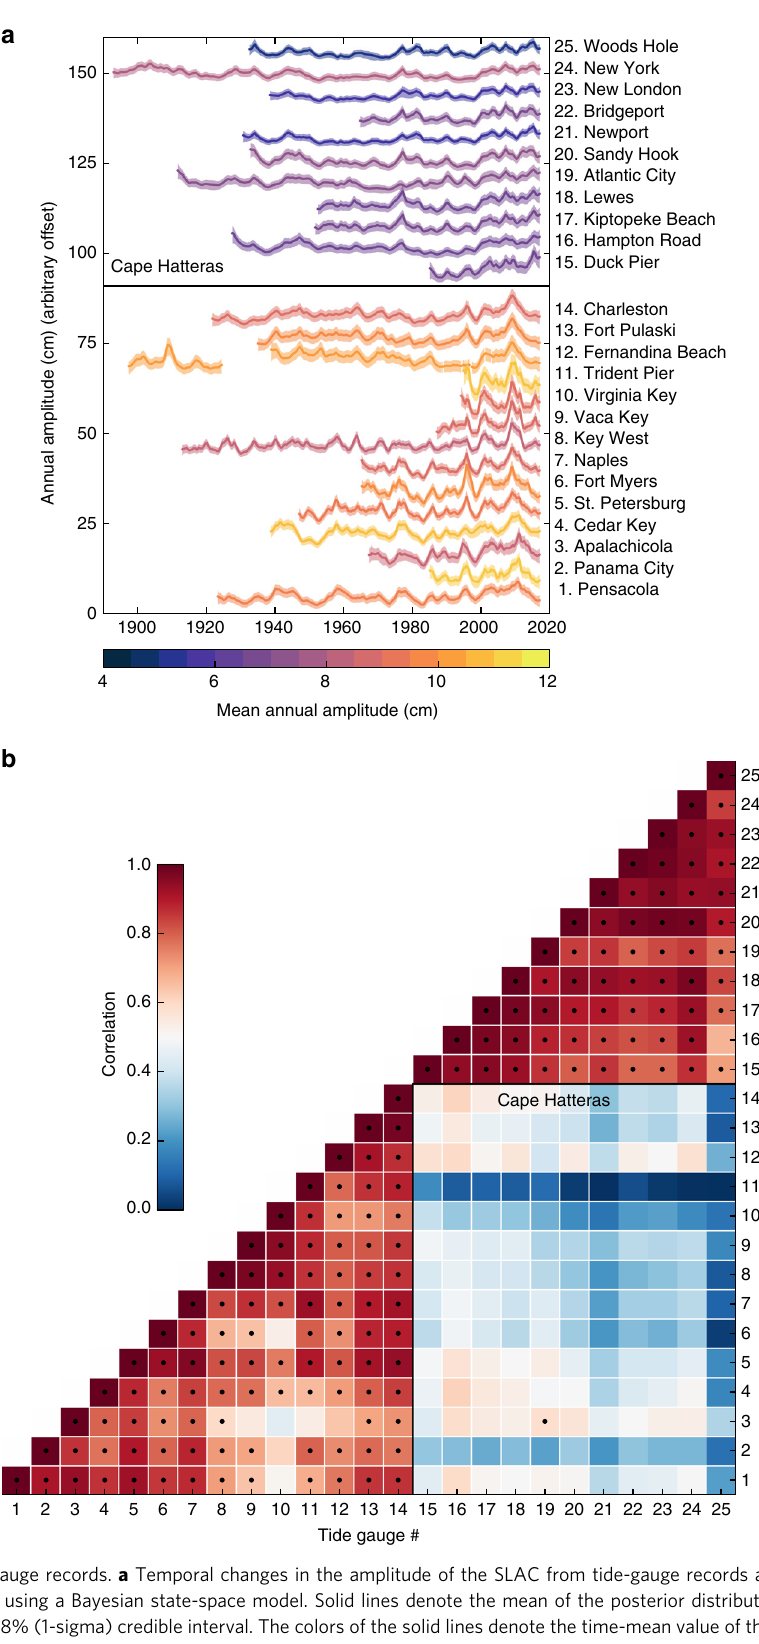
Fig. 1 Amplitude from tide-gauge records. a Temporal changes in the amplitude of the SLAC from tide-gauge records along the United States Gulf and Atlantic coasts as estimated using a Bayesian state-space model. Solid lines denote the mean of the posterior distribution at each time step, whereas shaded areas represent the 68% (1-sigma) credible interval. The colors of the solid lines denote the time-mean value of the annual amplitude. The name of each station along with their identi fi cation number are also shown (see Supplementary Fig. 1 for tide-gauge locations). b Correlation matrix of the time series shown in a . Numbers along the axes represent tide-gauge identi fi cation numbers, whereas black dots denote signi fi cant correlation at the 95% con fi dence